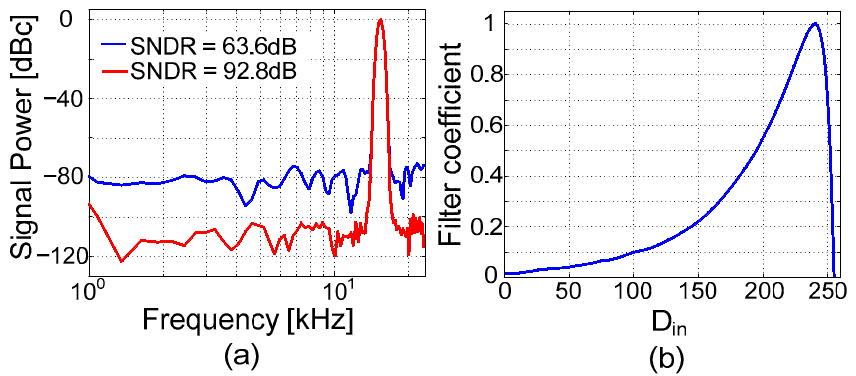
Figure 14. ( a ) Simulated output spectrum from transistor-level circuit simulation in 65 nm complementary metal-oxide-semiconductor (CMOS) model with the optimal filter (red) and the CoI filter (blue) when OSR = 256, and ( b ) the normalized coefficients of the optimal filter.